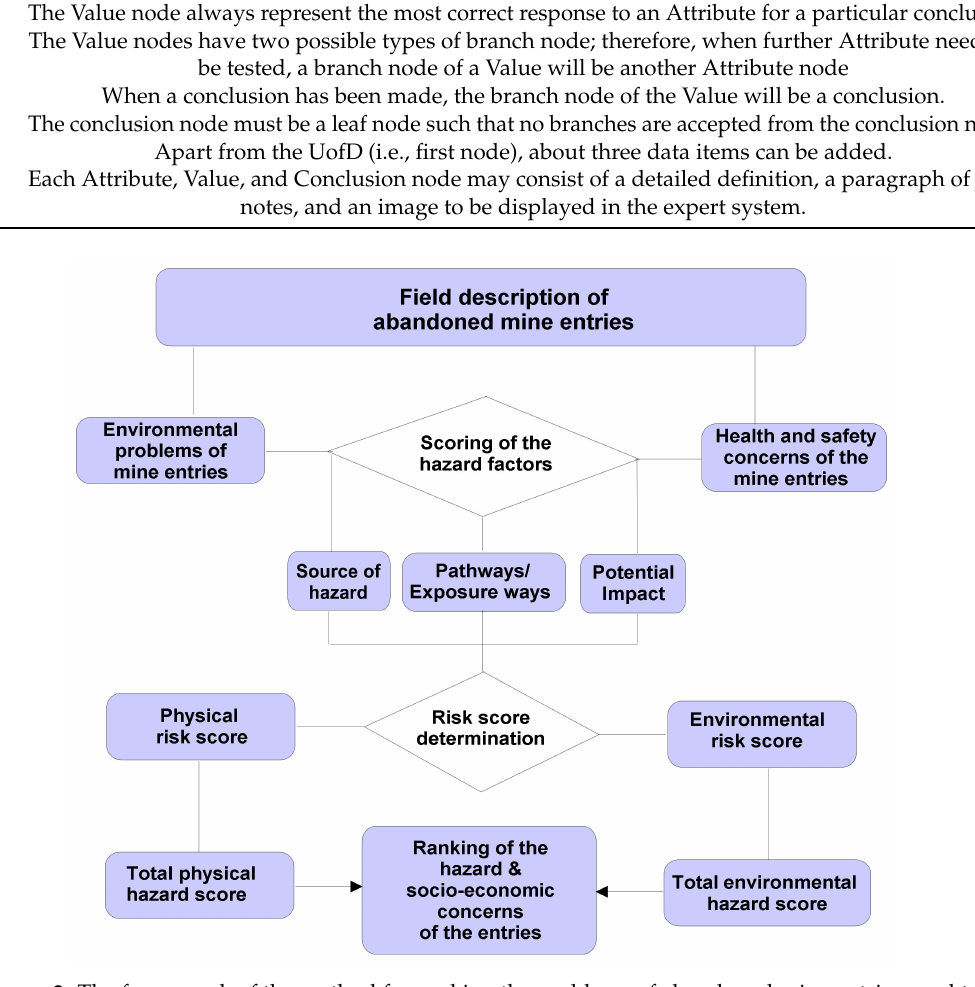
Figure 2. The framework of the method for ranking the problems of abandoned mine entries used to develop the production rules of the expert system for ranking problems of abandoned mine entries